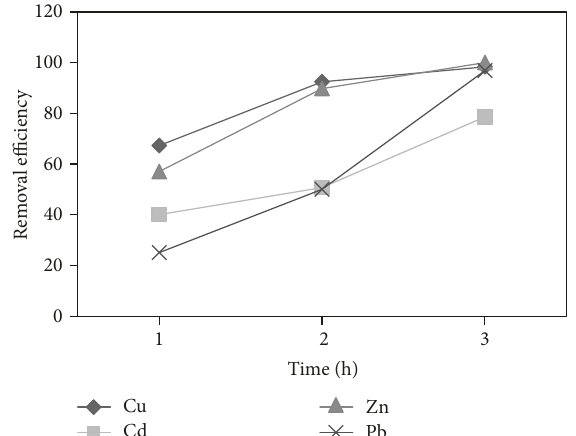
Figure 4: Effects of electrocoagulation time on Cu 2+ , Cd 2+ , Pb 2+ , and Zn 2+ removal efficiency. Density of current (8mA/cm 2 ), volume of 2 L, pH: 5.27 to 5.91, and 180 minutes of treatment [52].